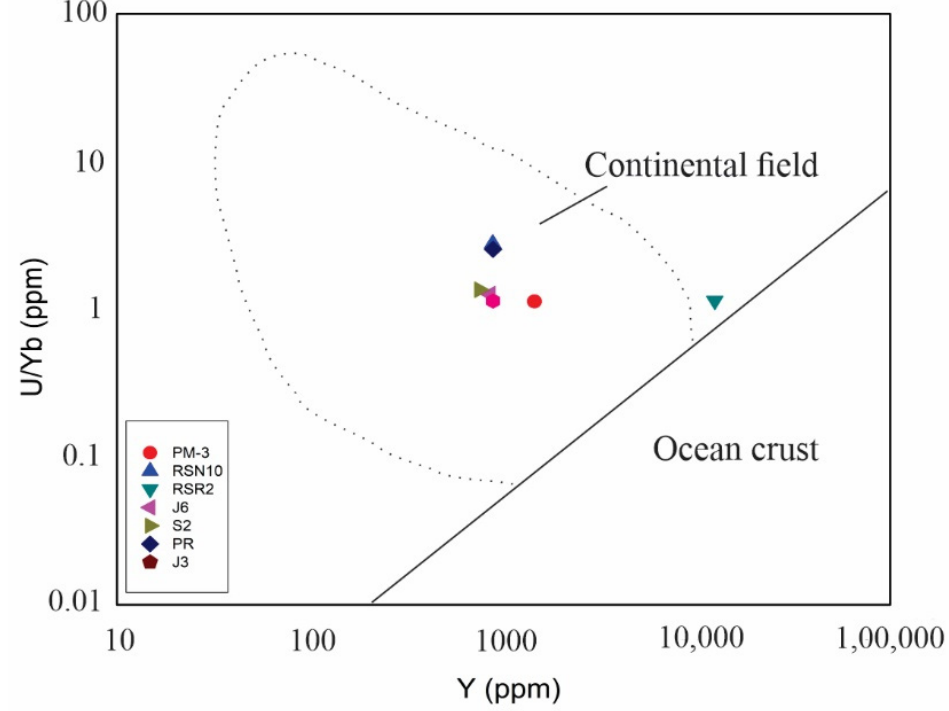
Figure 6. Discriminant diagram based on U/Yb vs. Y modified after [12] showing that all zircon grains from this study were derived from the continental crust. The samples studied from seven selected locations were found to be enriched in P, especially the samples from the Rushikulya river (RSR2), Podampata (PM-3) and Jahania beach (J3), respectively (Table 1). The presence of P is not only confined to the